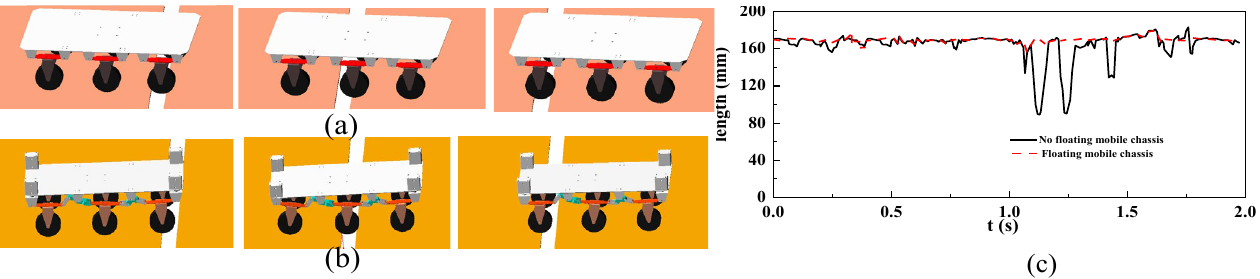
Figure 11. Motion simulation of trench obstacle crossing: ( a ) the obstacle climbing process of no floating mobile chassis; ( b ) the obstacle climbing process of floating mobile chassis; ( c ) simulation results–change curve of centroid height of two types of the plates.